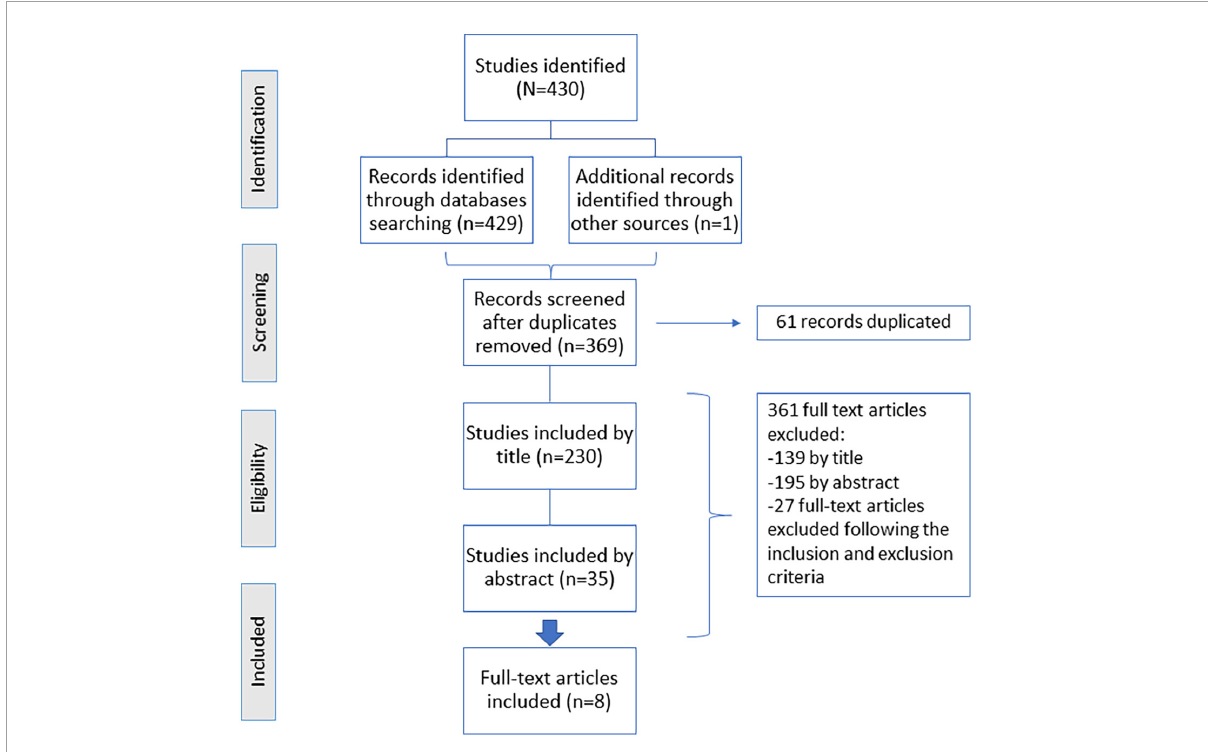
FIGURE1 Flow diagram showing the process of study